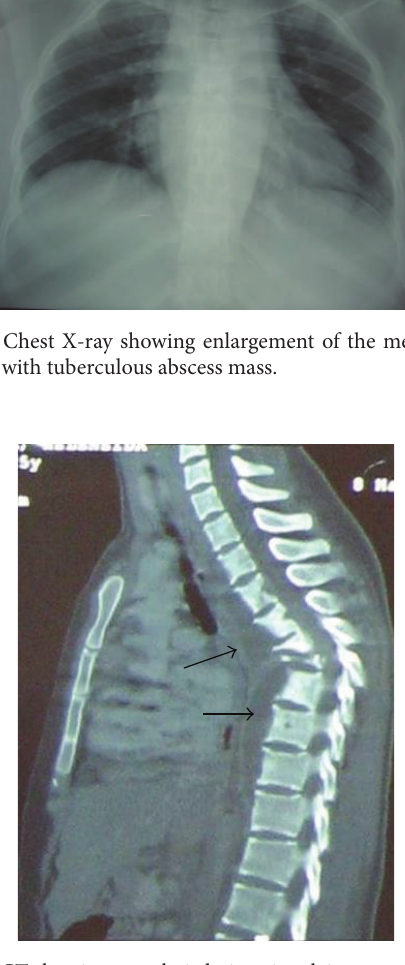
Figure 4: CT showing osteolytic lesions involving several vertebral bodies with severe kyphotic deformity, due to the collapse of the anterior spinal